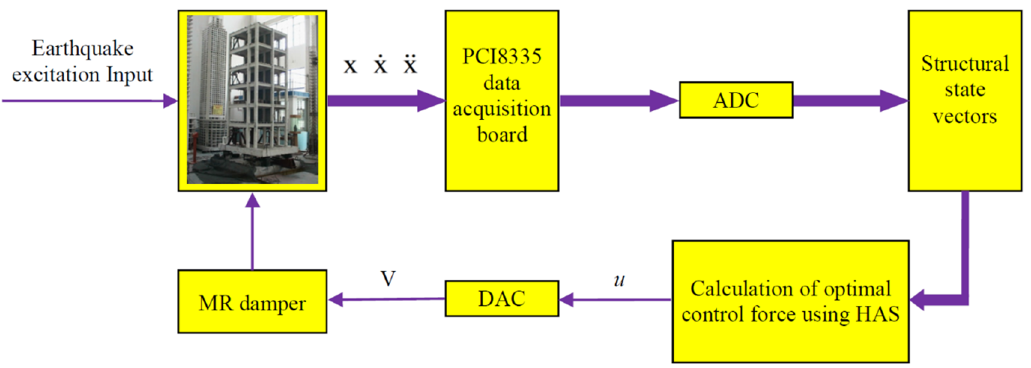
Figure 1. Flow chart for the configuration of control system.